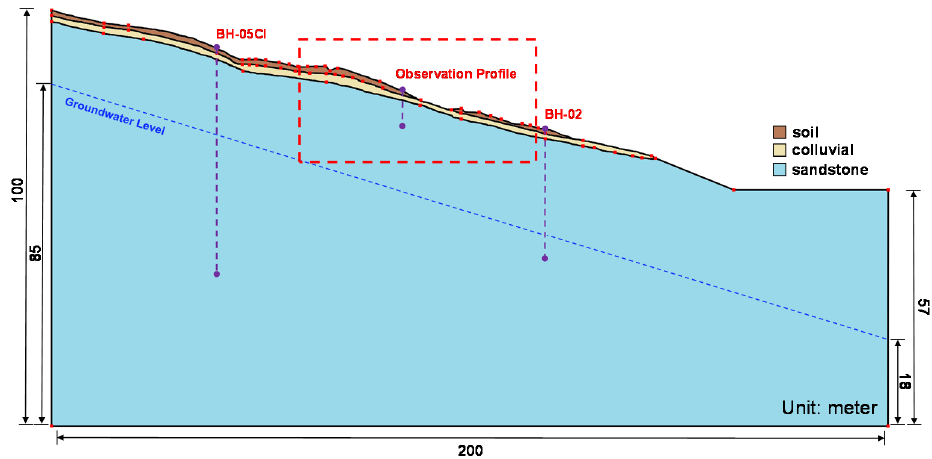
Figure 1. The conceptual model of the slope. Table 1. Soil mechanical